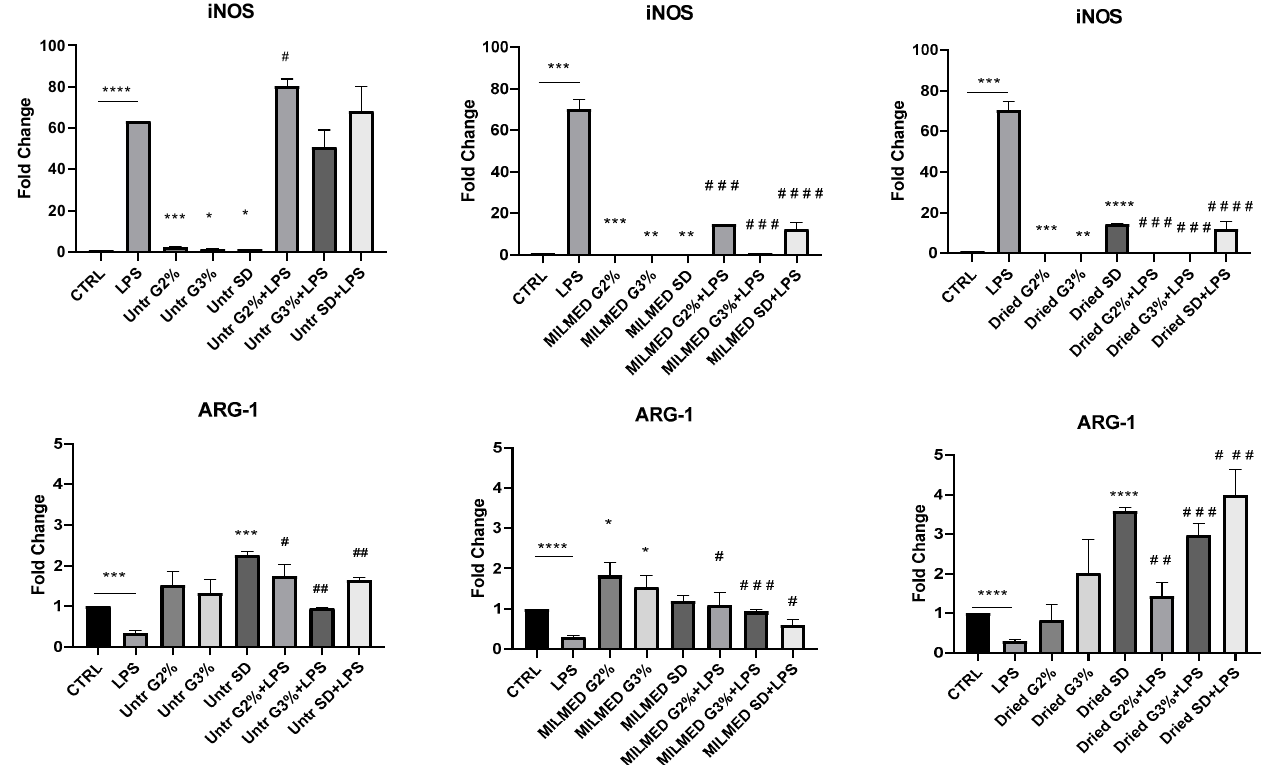
Figure 3. BV2 cells were pretreated with 5 × 10 2 Milmed/well grown in Yeast Extract–Peptone– Dextrose (YPD) medium or regrown in YPD medium from a dried preparation for 45 min and afterward incubated with Lipopolysaccharide (LPS) 1 ng/mL. Inducible Nitric Oxide Synthase (iNOS) and Arginase-1 (ARG-1) mRNAs expressions were evaluated by qRT-PCR at 4 h and normalized to β -actin. Data are shown as mean ± SD from three independent experiments performed in triplicate. Statistical analysis was evaluated by unpaired Student’s t test. Expression profiles were determined using the 2 −ΔΔ CT method. * p < 0.05, ** p < 0.01. *** p < 0.001, **** p < 0.0001; ## p < 0.01; ### p < 0.001; #### p < 0.0001 * VS CTRL, # VS LPS.